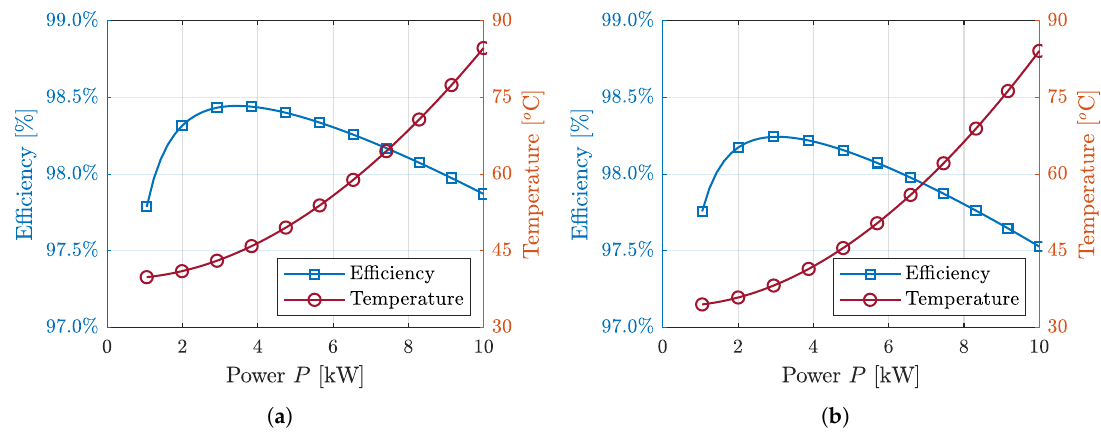
Figure 7. Calculated efficiency and temperature obtained by: ( a ) optimized parameters; ( b ) competing parameters.